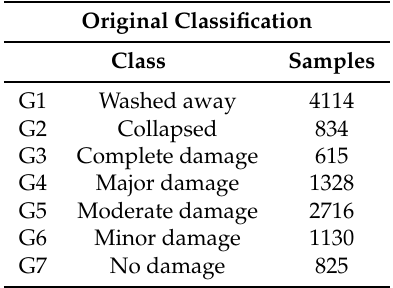
Table 2. Ground truth data provided by MLIT.